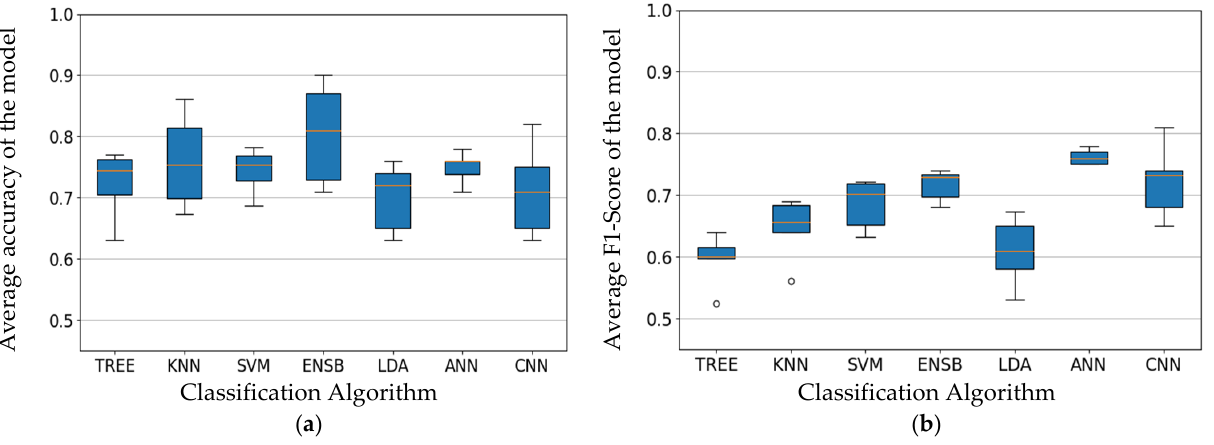
Figure 5. ( a ) Average accuracy for models trained for all subjects and sliding window across differ- ent classification algorithms. ( b ) Average F1-score for models trained for all subjects and sliding window across different classification algorithms. Orange line refers to the median performance metric and circles depict the outliers in the distribution.